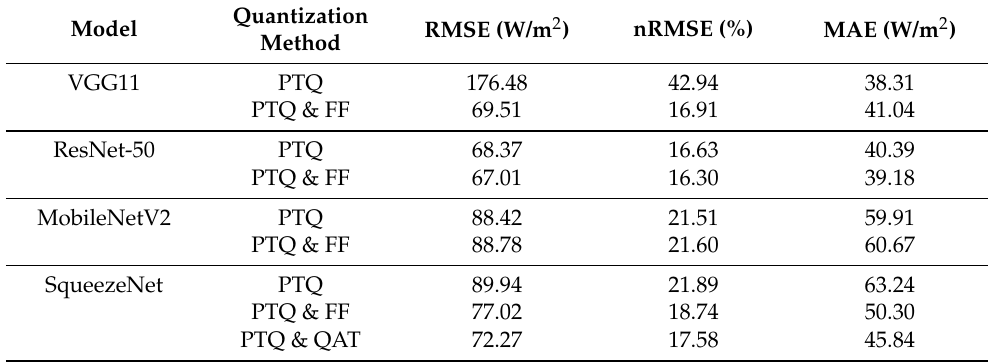
Table 4. Performance metrics for the four quantized models with combinations of PTQ, FF, and QAT.